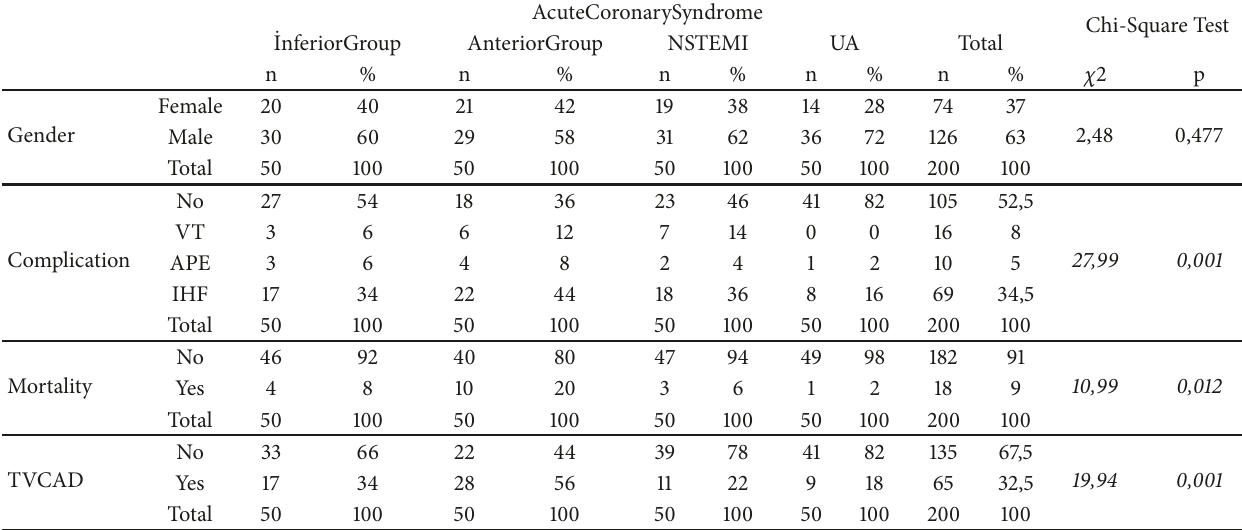
Table 1: Chi-Square test result relation between acute coronary syndrome and variables.